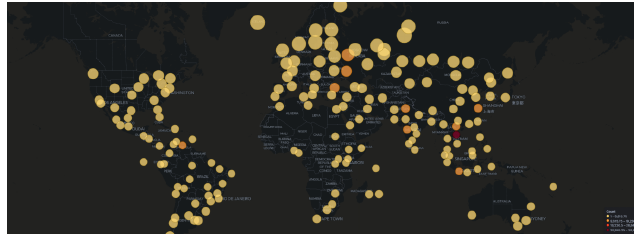
Figure 10. Microsoft Azure Honeypot Attack